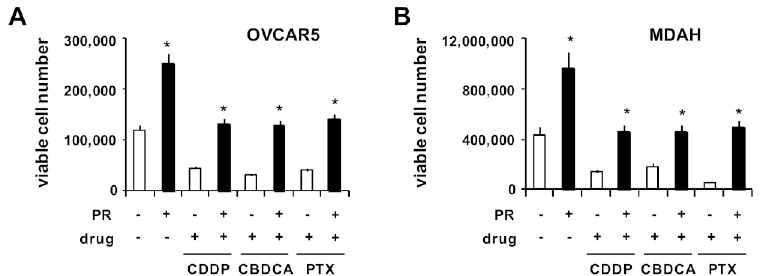
Figure 3. PR increased OvCa cell viability and survival after drug treatment. OvCa cells were cultured for 5 days with PR (10%) on poly-HEMA-coated wells to form spheroids. Then, cells were treated with CDDP, CBDCA and PTX. After 72 h of drug treatment, OvCa spheroids were dissociated into single-cell suspensions by trypsinization and the number of viable cells was evaluated. Histograms showing OVCAR5 ( A ) and MDAH ( B ) viable cell numbers evaluated by the trypan blue dye exclusion assay. * p < 0.01 (untreated vs. PR-treated